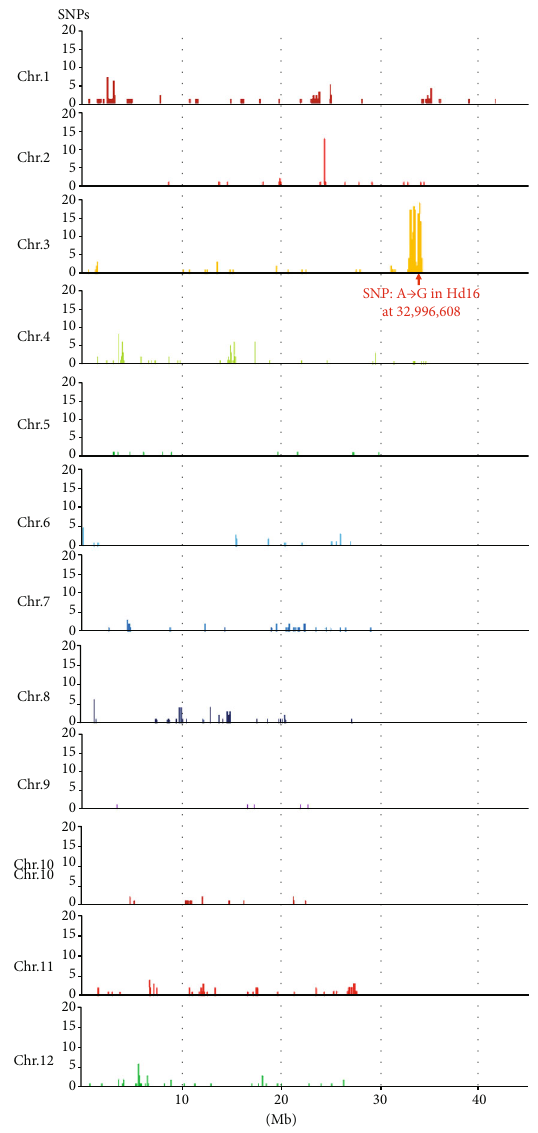
Figure 6: Frequency distribution of SNPs per 0.1Mb in the genome of late-maturing isogenic Koshihikari (BC whole-genome sequencing. There were less than 10 SNPs per 0.1Mb over all genomes, except for a SNP cluster around the 33Mb region of chromosome 3 (yellow bar graph), which contained over 15 SNPs per 0.1Mb. This SNP-concentrated region derived from Isehikari was also detected by linkage analysis with SSR markers (Figure 1). A large portion of the 12 chromosomes were substituted with the genome sequence of Koshihikari after 6 times of continuous backcross targeting a late- maturing